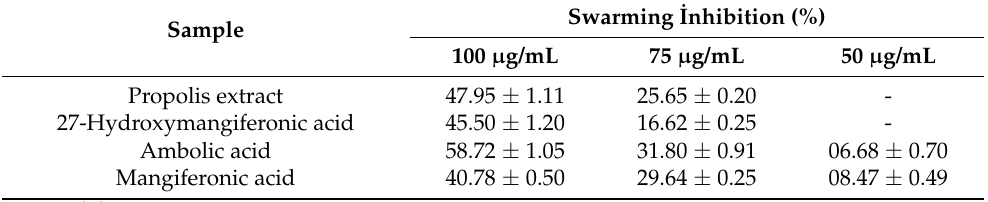
Table 6. Swarming motility inhibition on P. aeruginosa PA01 by propolis extract and isolated